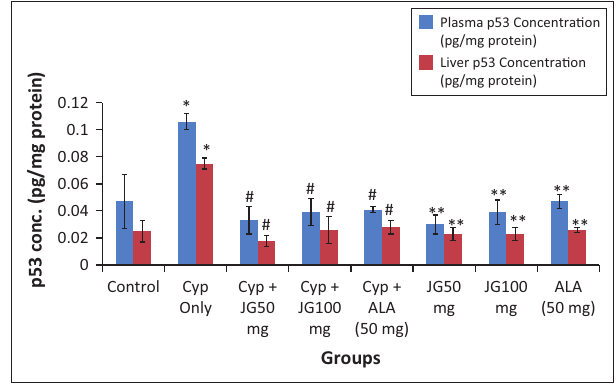
FIGURE 1: Effect of crude methanolic leaves extract of Jatropha gossypifolia ( J. gossypifolia 50 mg and J. gossypifolia 100 mg) and alpha-lipoic acid ( α -LA 50 mg) on the mean number of micronucleated polychromatic erythrocytes in rats pretreated with cypermethrin.